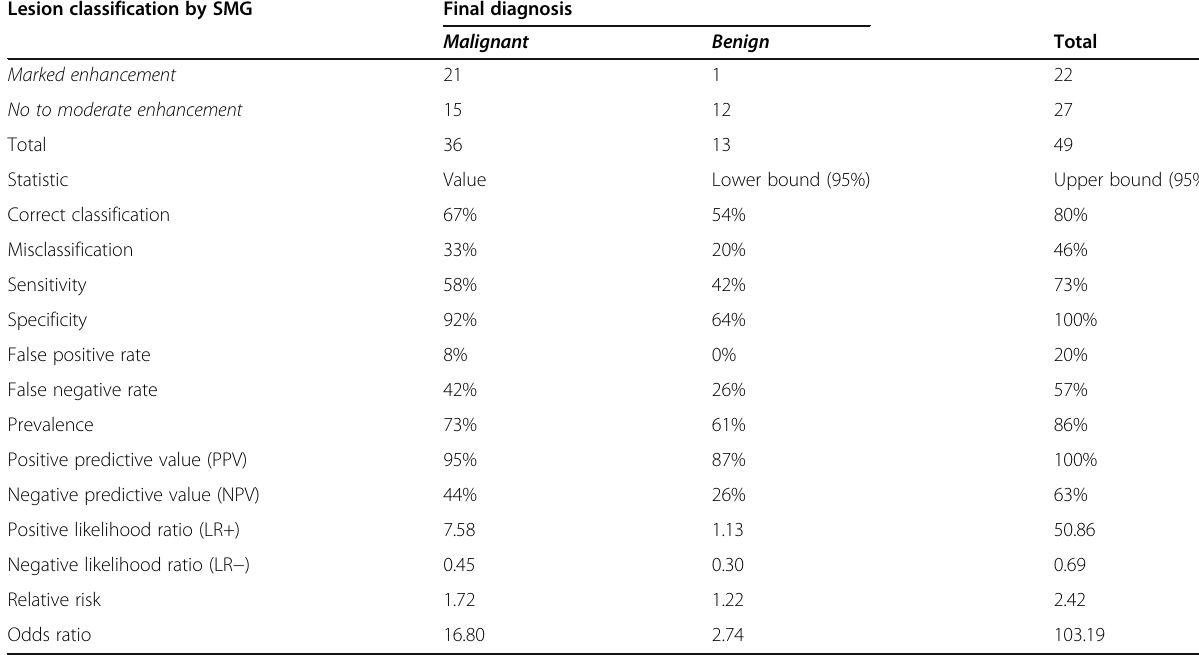
Table 17 Diagnostic accuracy of marked enhancement on CESM in patients with ACR grade A/B Lesion classification by SMG